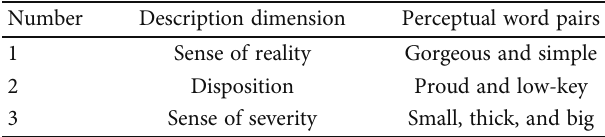
Table 2: Semantics of sweeping